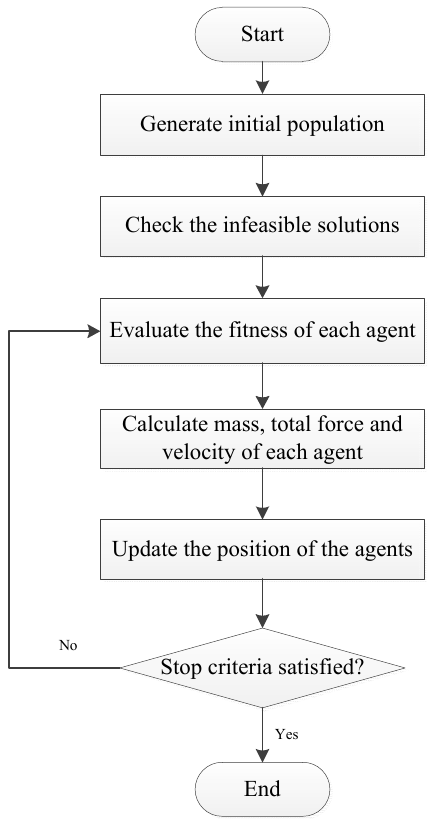
Figure 6. Flowchart of GSA.